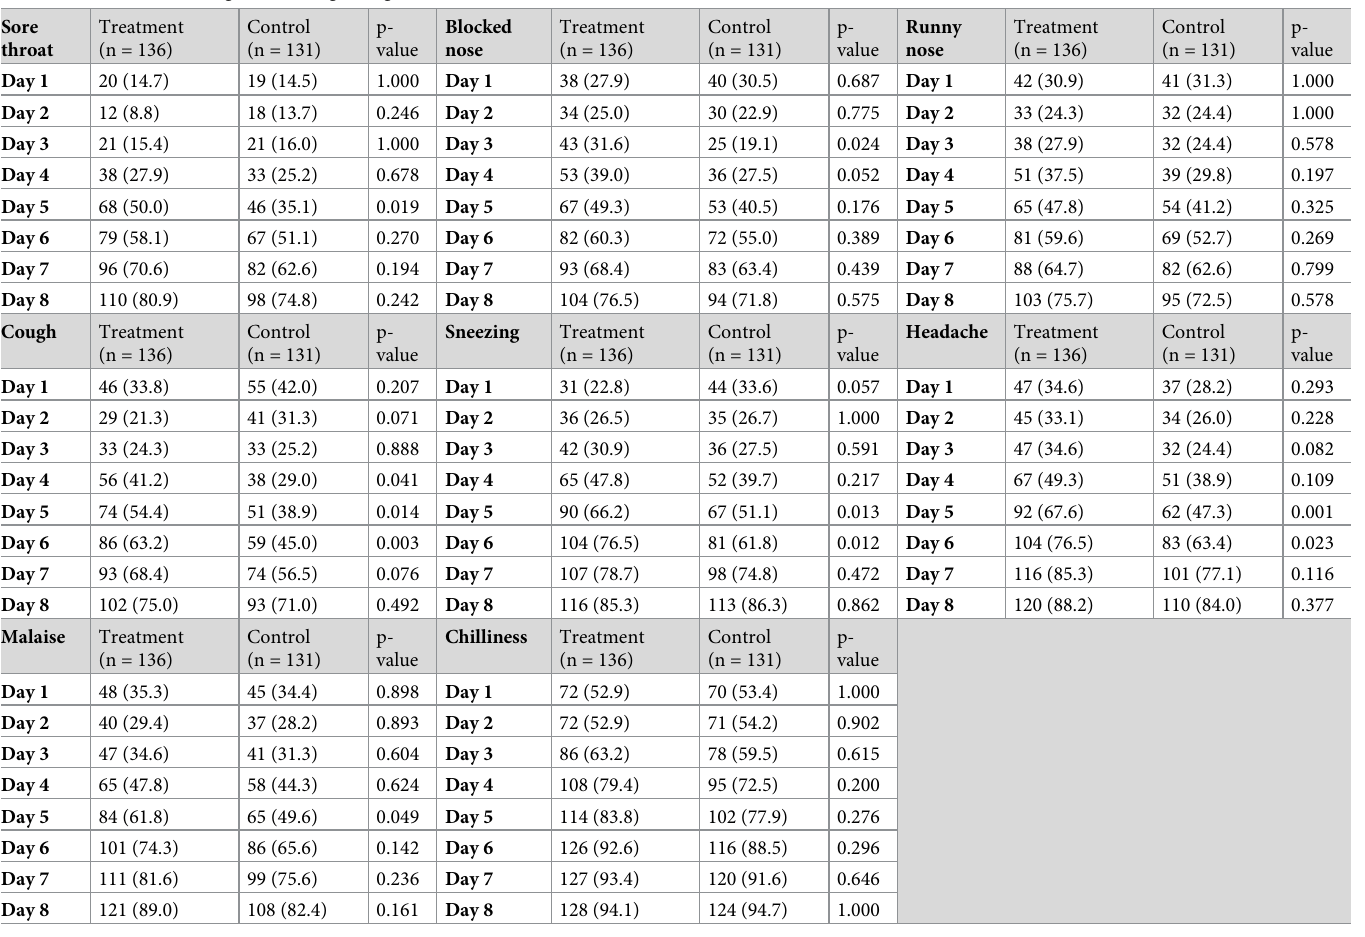
Table 2. Number of subjects (% of subjects in respective group) without symptoms for each individual item of the Jackson score during the first 8 days of the com- mon cold (mean of morning and evening